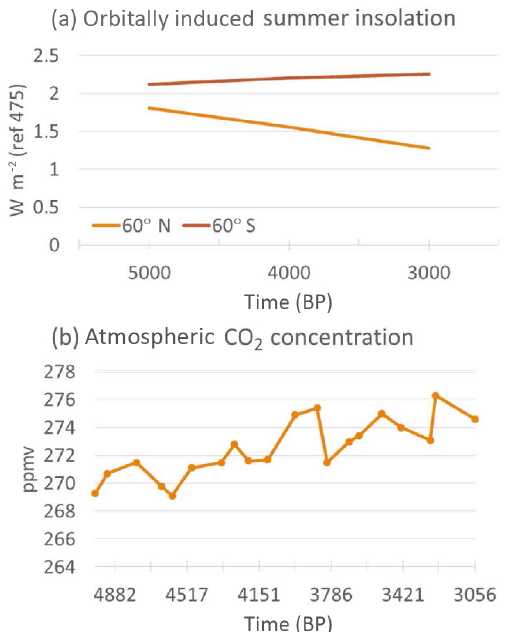
Figure 1. Time series of (a) transient summer insolation (at 60 ◦ N and 60 ◦ S) changes resulting from the orbital variation and (b) the transient CO 2 change used in the simulations. Figure 2. Time series of annual mean NH (a) surface temperature